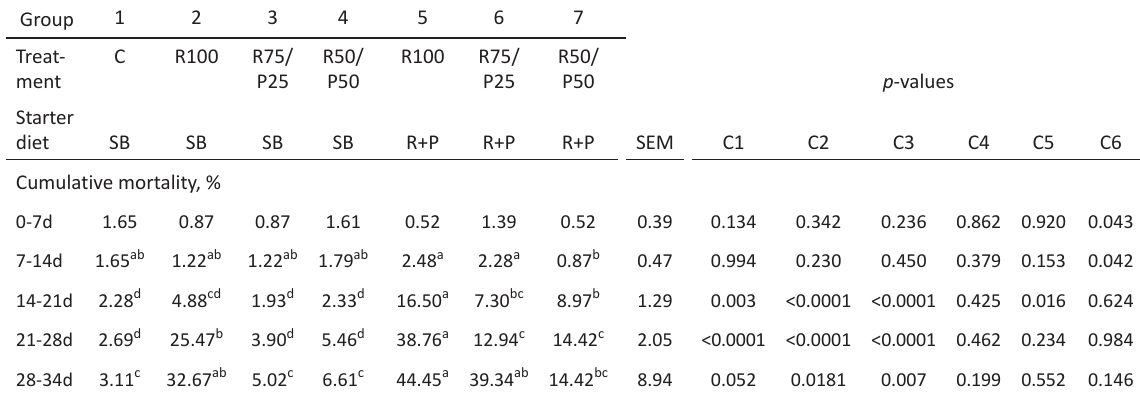
Table 6. The effect of diets with soybean meal (SB), rapeseed meal (R), or rapeseed meal and peas (P) on cumulative mortality of broilers Group